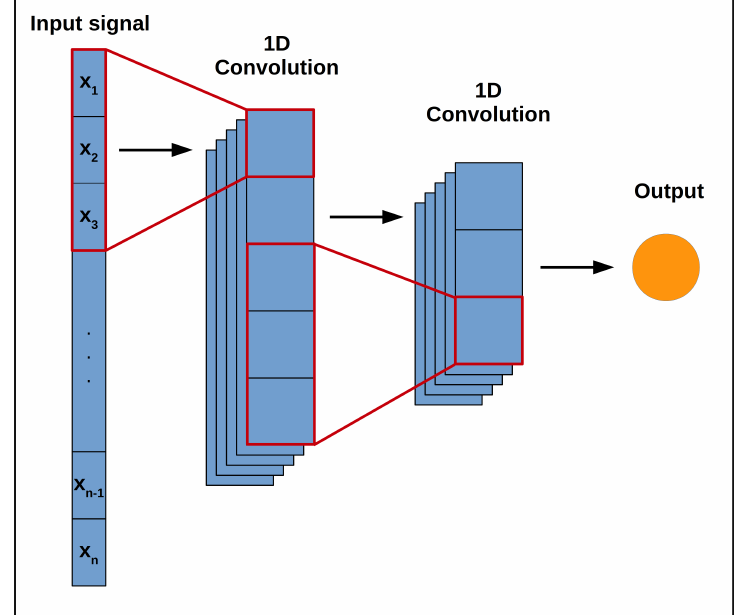
Figure 1. Simple 1D convolutional neural network (CNN) architecture with two convolutional